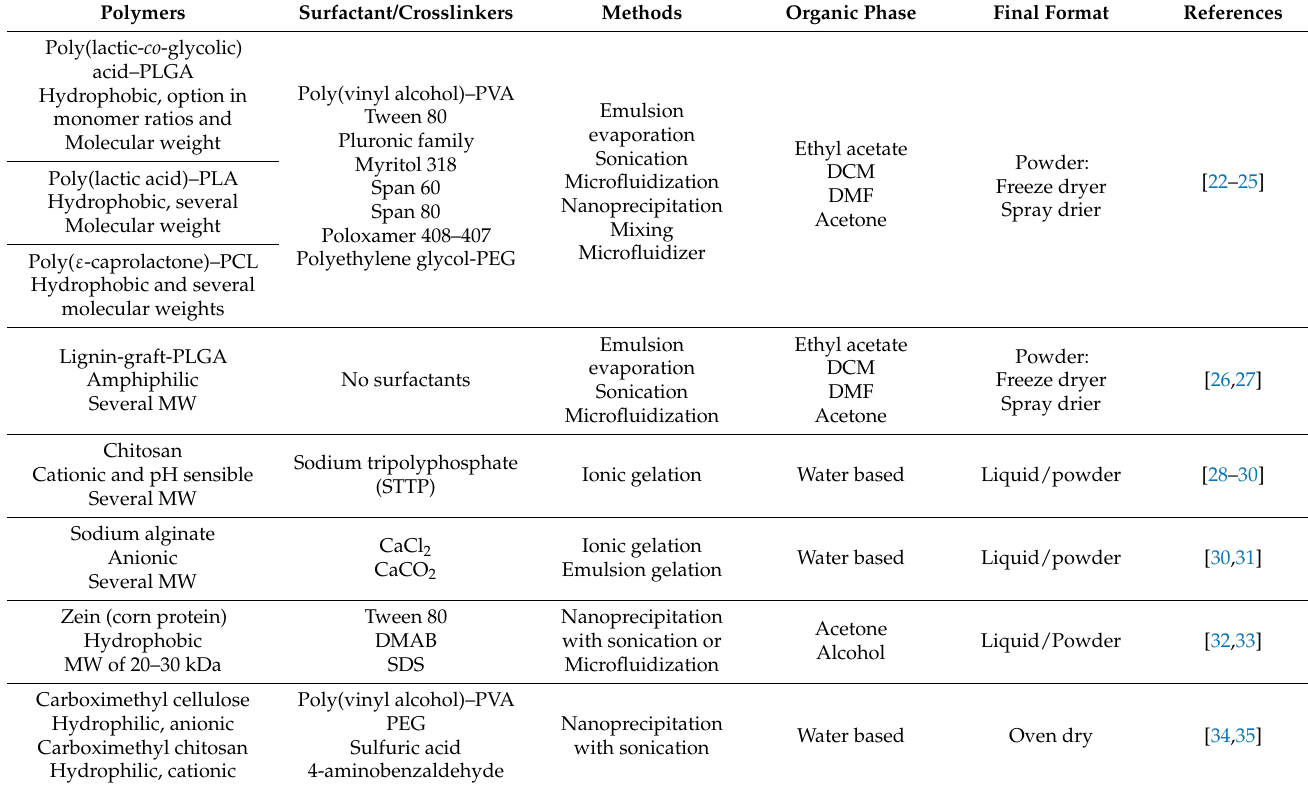
Table 1. Summary of main components used in common pbENP